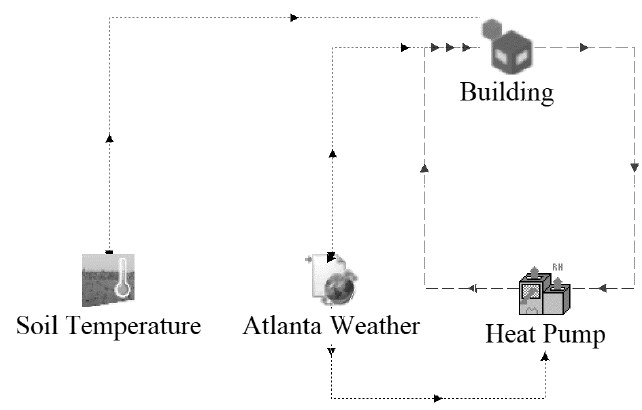
Figure 1. Transient System Simulation Tool (TRNSYS) Schematic for Reference Building.